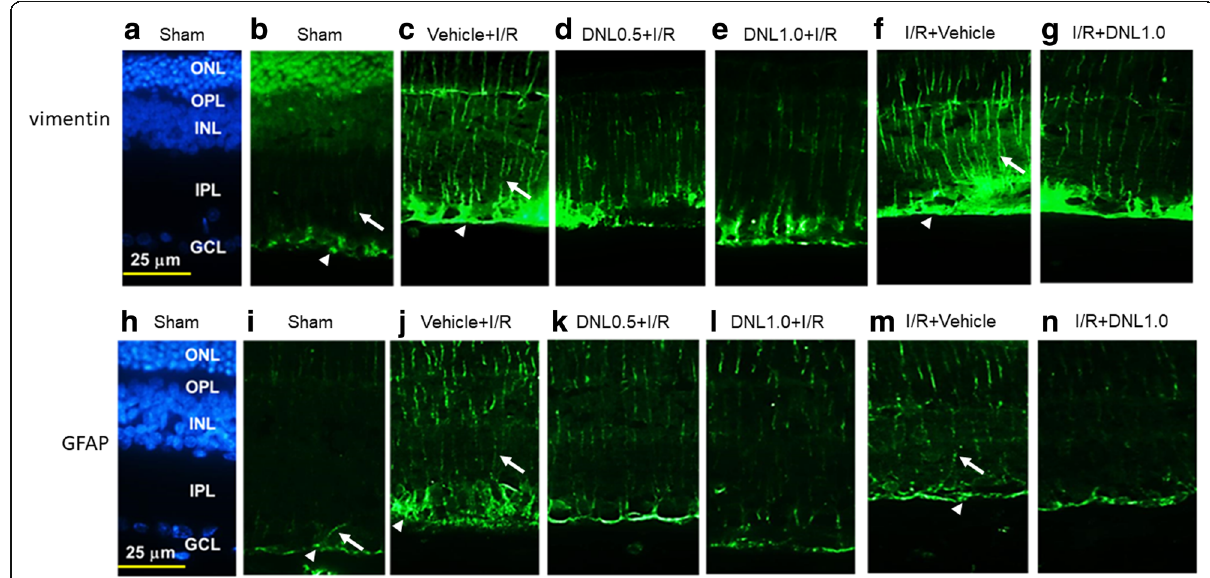
Fig. 7 Vimentin immunohistochemistry. b After the sham procedure (Sham), anti-vimentin (green) immunoreactivity can be seen in the end feet of Müller cells (arrow heads; see also c and f ) within the ganglion cell layer (GCL) as well as their processes are also immunolabeled in the IPL (arrows; see also c and f), INL and ONL. c , f Compared to the sham retina, there was a considerable enhancement of the anti-vimentin immunolabeling after ischemia and pre-administration or post-administration of vehicle (Vehicle+I/R or I/R+Vehicle). d , e , g This enhancement was obviously counteracted by pre-administration of 0.5 g/kg/day (DNL0.5+I/R), or 1 g/kg/day of DNL (DNL1.0+I/R), or post-administration of 1 g/kg/day of DNL (I/R+DNL1.0). GFAP immunohistochemical study. After the sham procedure (Sham; i ), the Müller cells displayed GFAP immunoreactivity at their end feet within the GCL (arrow heads; see also j and m ), and at their processes in the IPL (arrows; see also j and m ), INL and ONL. Compared to the Sham retina, anti- GFAP immunolabeling was enhanced after ischemia and pre-administration/post-administration of vehicle (Vehicle+I/R, j ; I/R+Vehicle, m ). This enhancement was mitigated by pre-administration of 0.5 g/kg/day (DNL0.5+I/R; k ) or 1 g/kg/day of DNL (DNL1.0+I/R; l ), or post-administration of 1 g/kg/day of DNL (I/R+DNL1.0; n ). a , h DAPI (blue) was used to counterstain cell nuclei in the sham retina. DNL, Dendrobium nobile Lindley. GFAP, glial fibrillary acidic protein; IPL, inner plexiform layer; INL, inner nuclear layer; ONL, outer nuclear layer; DAPI, 4,6-diamidine-2-phenylindole dihydrochloride. Scale bar=25 μ